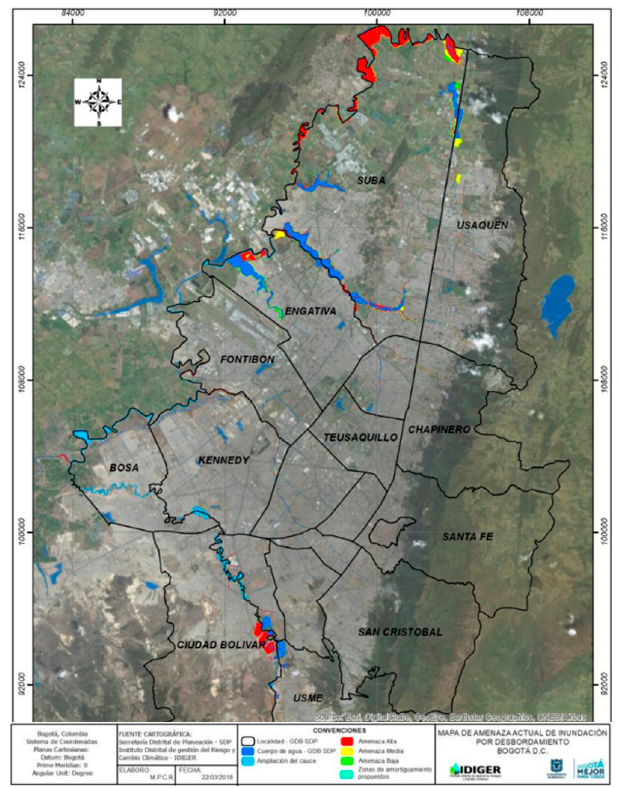
Figure 1. Flood threat from the perspective of Climate Change, prospective scenario [20].